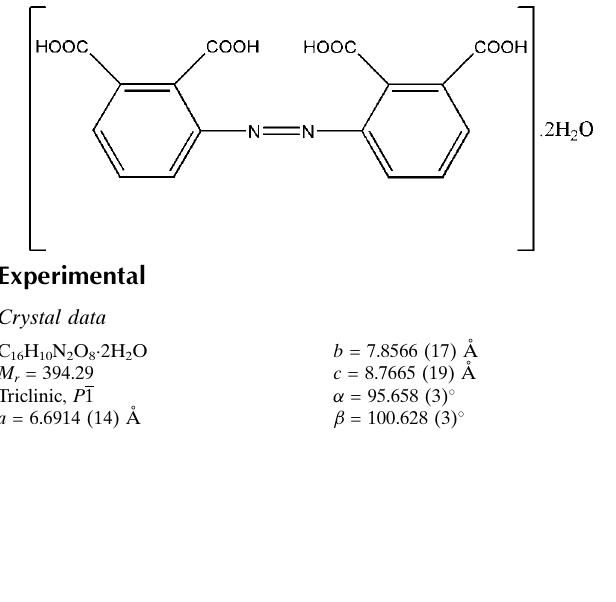
Related literature For related literature, see: Carlucci et al. (2000).